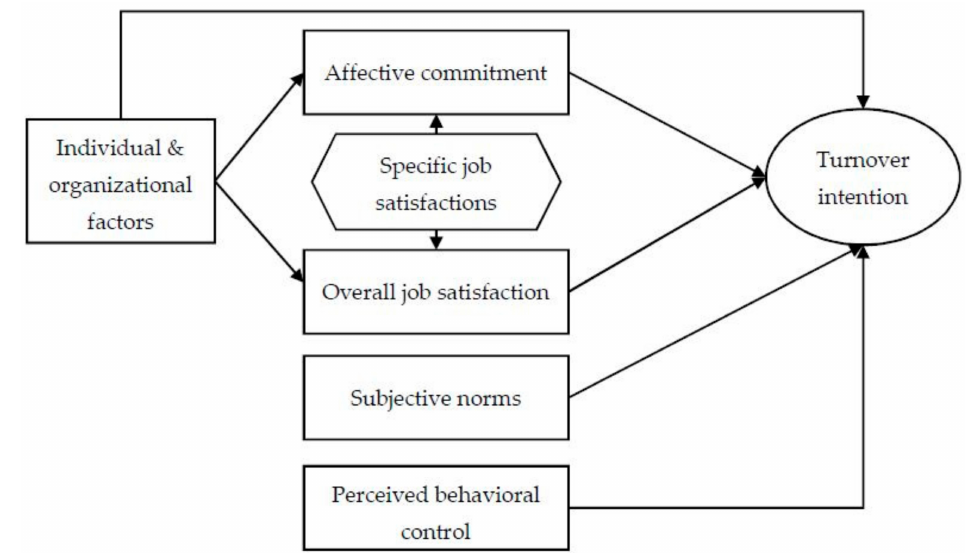
Figure 1. The conceptual framework of turnover